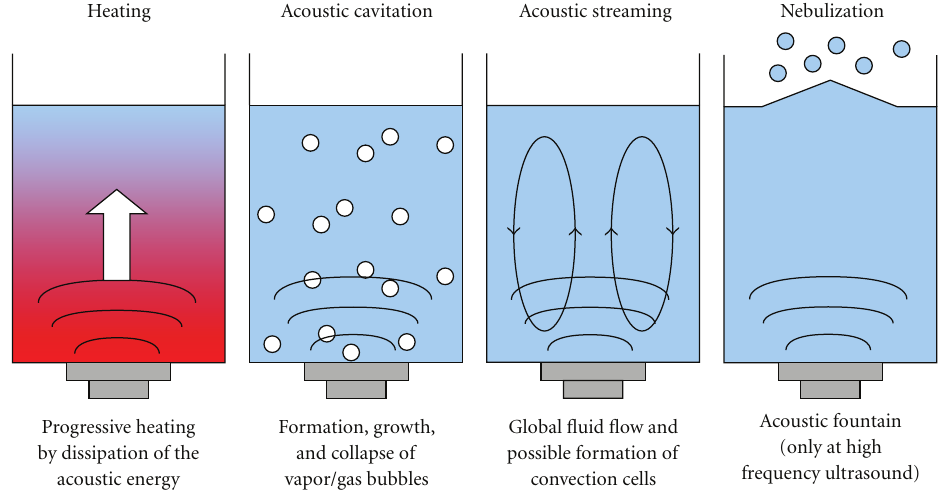
Figure 2: Four e ff ects resulting from ultrasound propagation in a liquid.